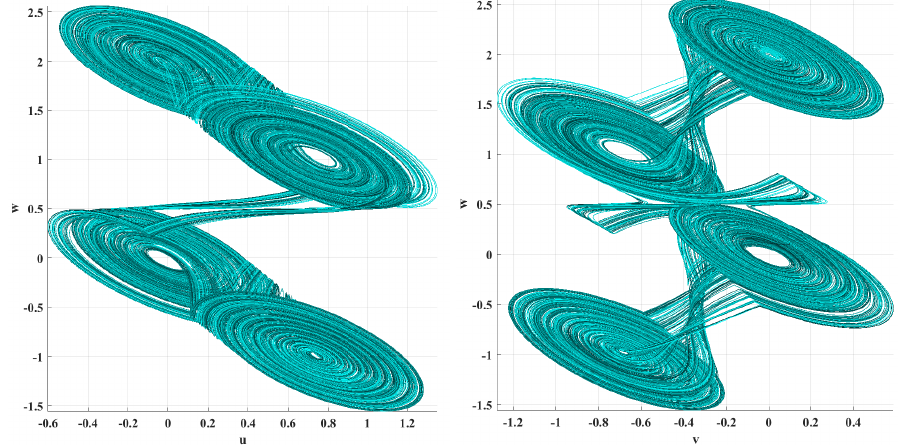
Figure 3. Three-dimensional rotation example at ( θ 1 , θ 2 , θ 3 ) = ( 90 ◦ ,90 ◦ ,45 ◦ )